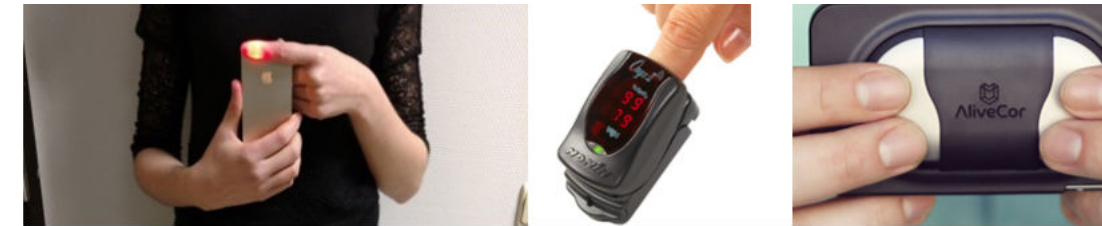
Figure 4. Graphical representation of how measurements are performed using the different devices. Left, FibriCheck application; Middle, Nonin oximeter; Right, AliveCor.